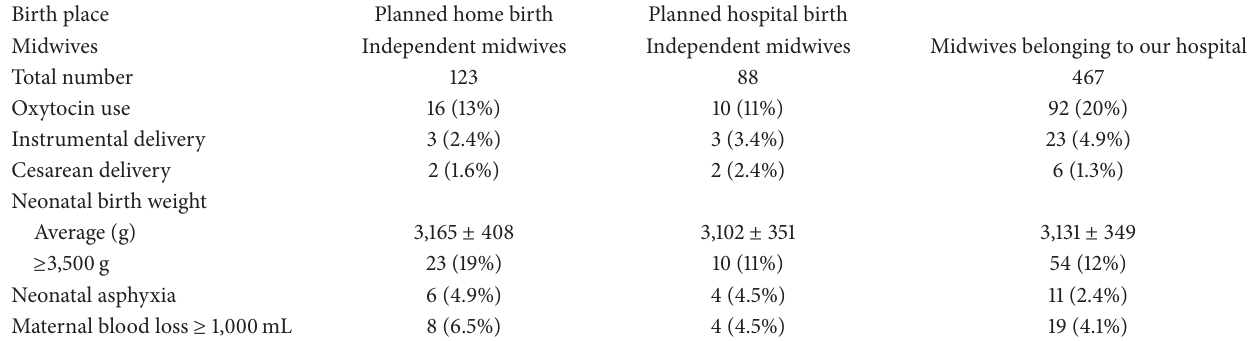
Table 3: Obstetric and neonatal outcomes in the pregnant women initially considered as “low-risk” for receiving our midwife-led primary delivery care